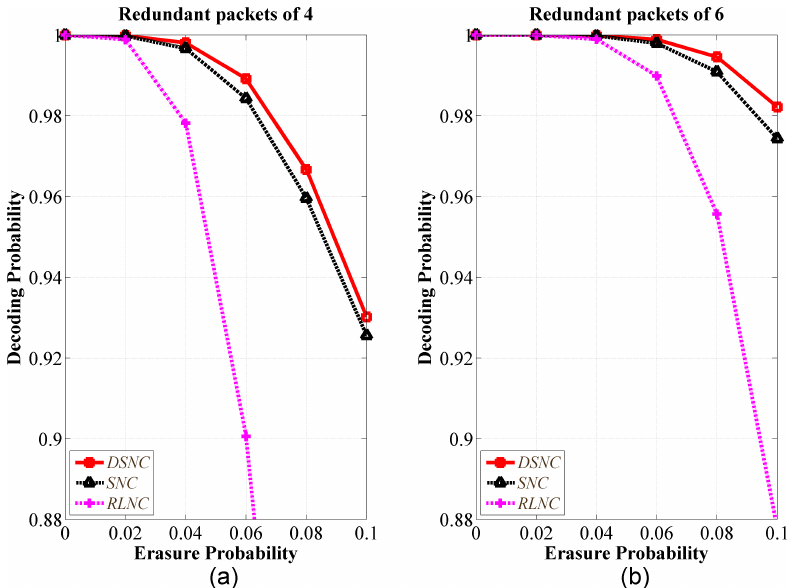
Figure 9. Performance comparison of decoding probability versus erasure probability with predefined redundancies; 2 ONs, K u = 30, and q = 256; ( a ) the number of redundant packets is 4; ( b ) the number of redundant packets is